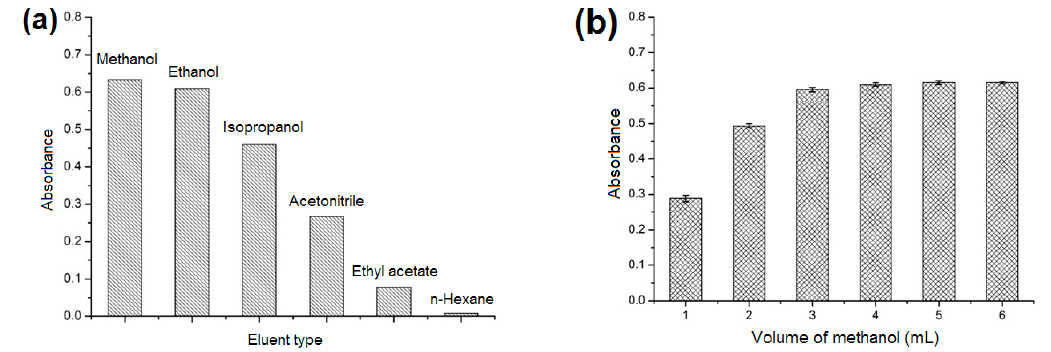
Figure 7. Optimization of ( a ) elution solvent; ( b ) elution volume. Analyte concentration: 3.0 mmol L − 1 ; sample volume: 2.0 mL.